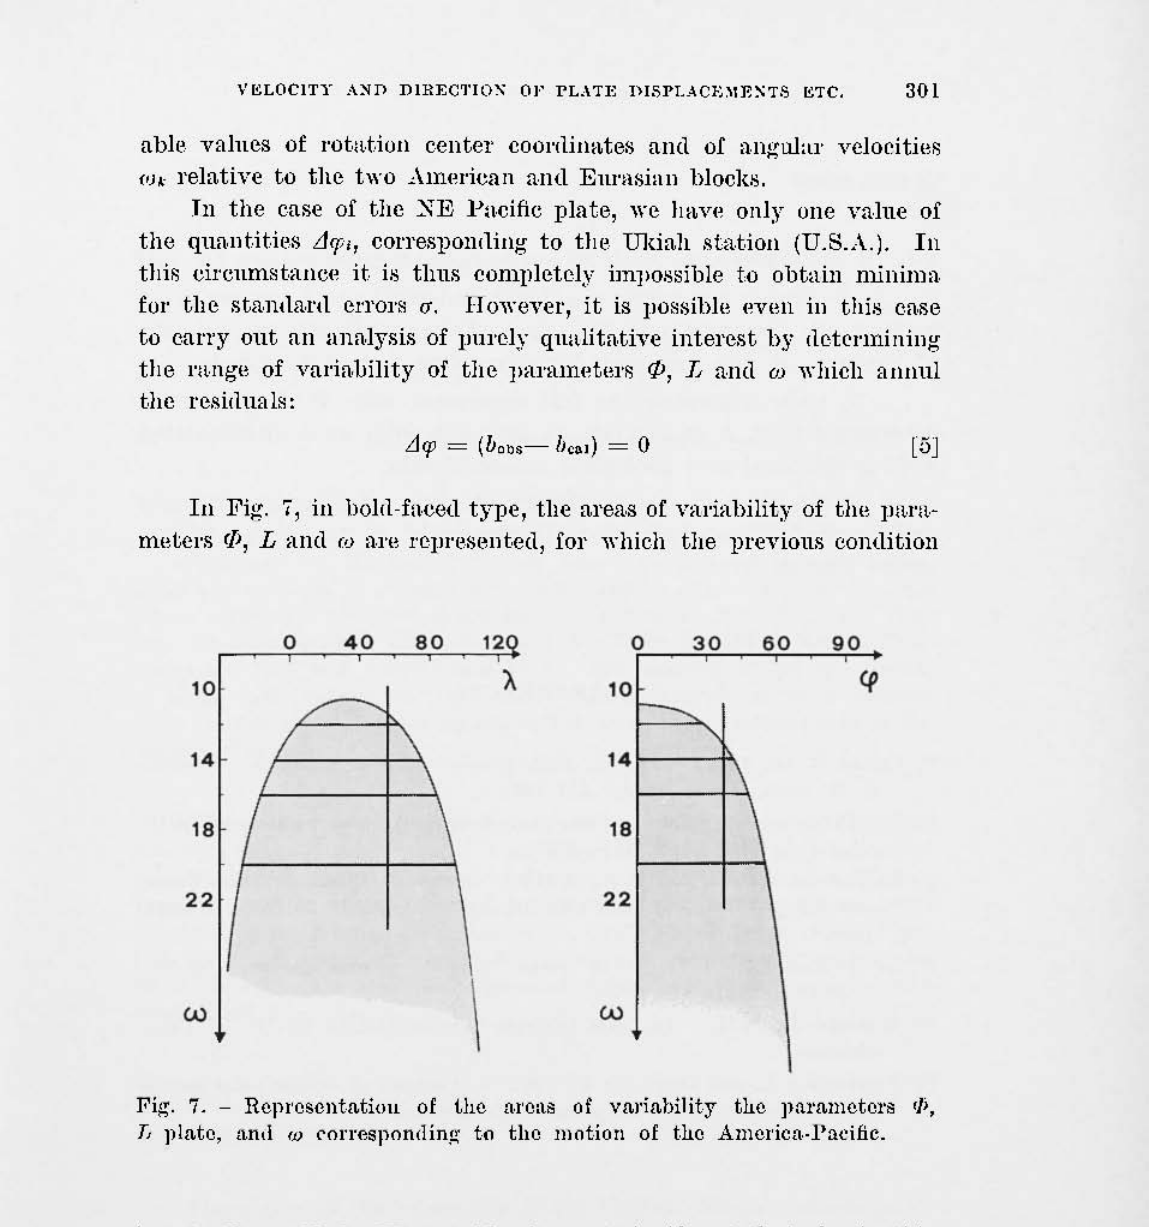
Fig. 7. - Rcpl'cscntatioll of thc a.I'CllS of variability thc ]Htl'amctCl's 'J;, J, ]l!atc, all,I w rorrespolldill.!; tll thc lllotion of thc